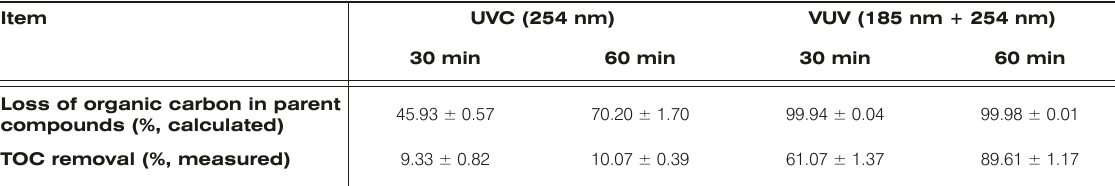
Table 5. Organic carbon removals due to UVC and VUV photolysis (n = 3) of selected PhCs in mixed ultrapure water solutions.